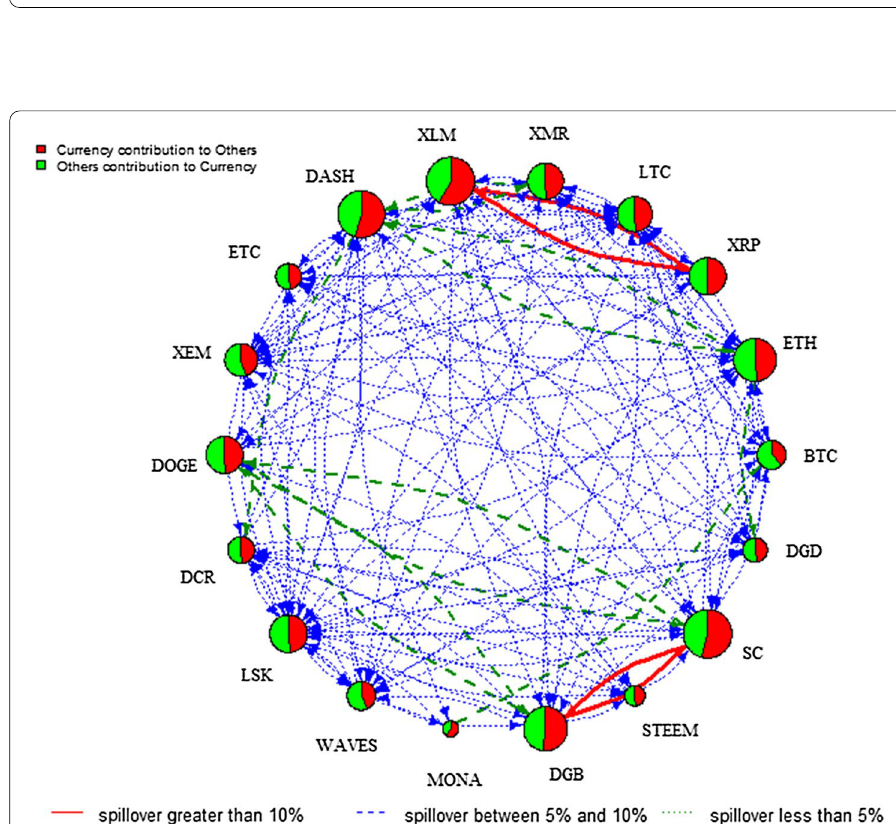
Fig. 5 DY Spillover network—high volatility regime. Note : See notes to Fig.